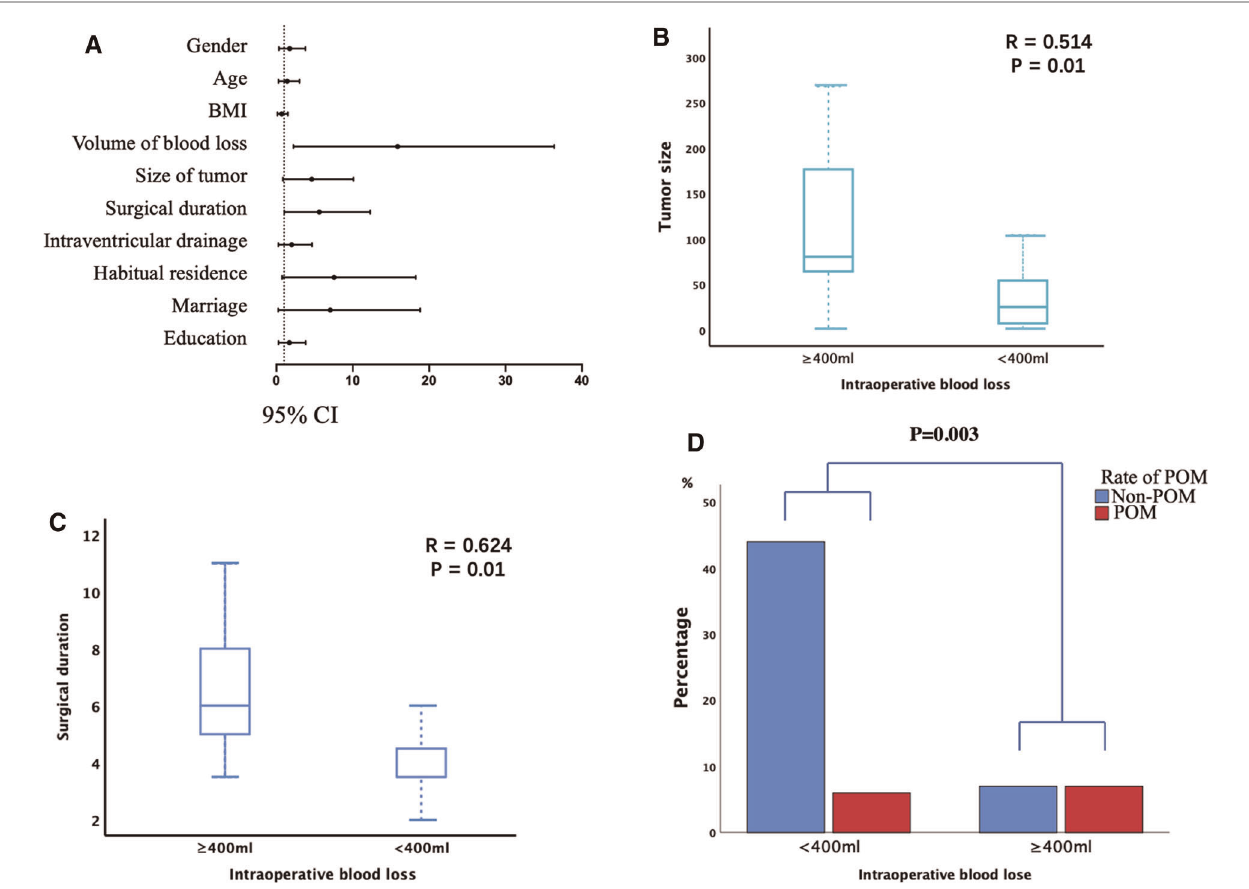
FIGURE 2 | The risk factors for postoperative intracranial infection (POM). ( A ) Univariate analyses of the risk factors for POM. Odds ratios are shown with 95% CIs. ( B,C ) Tumor size ( B ) and surgical duration ( C ) were signi fi cantly associated with intraoperative blood loss (IBL). ( D ) IBL ≥ 400 mL was associated with a signi fi cantly higher incidence of POM.